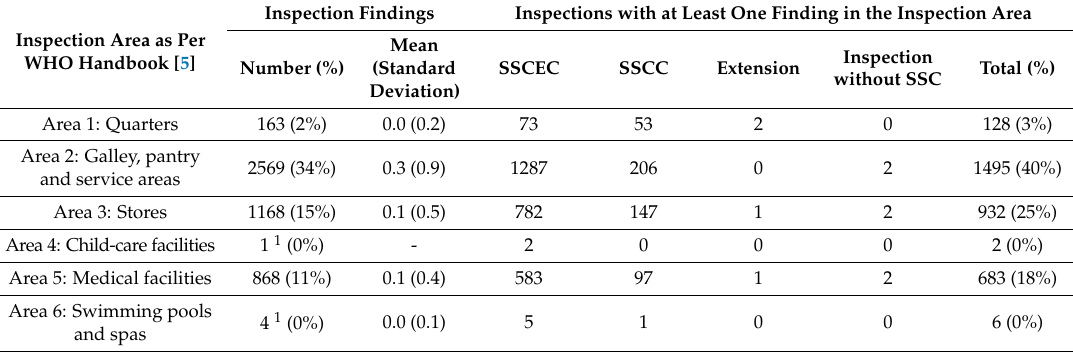
Table 3. Frequency of inspection findings per ship